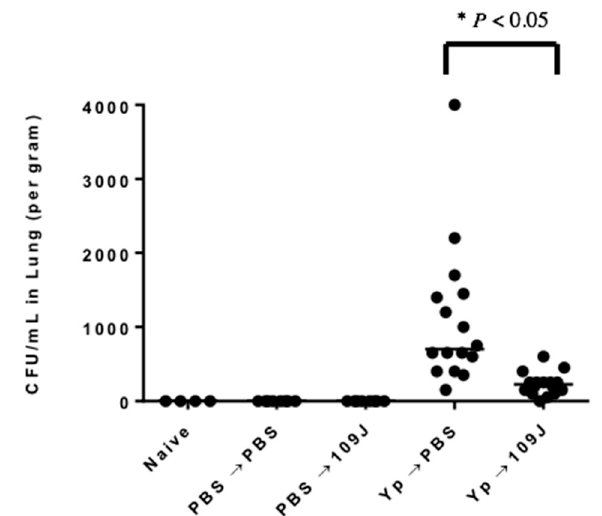
Figure 1. CFU/mL of Y. pestis CO92 recovered from entire lung at 24 h post-infection. Animals were exposed to 10 5 CFU of Y. pestis treated with predators at 30 min, 6, 12, and 18 h post-infection (4 doses). n = 16 per treatment group. Data presented as median. Significant differences between treatment groups and respective controls were analyzed using Mann-Whitney test (* p < 0.05).